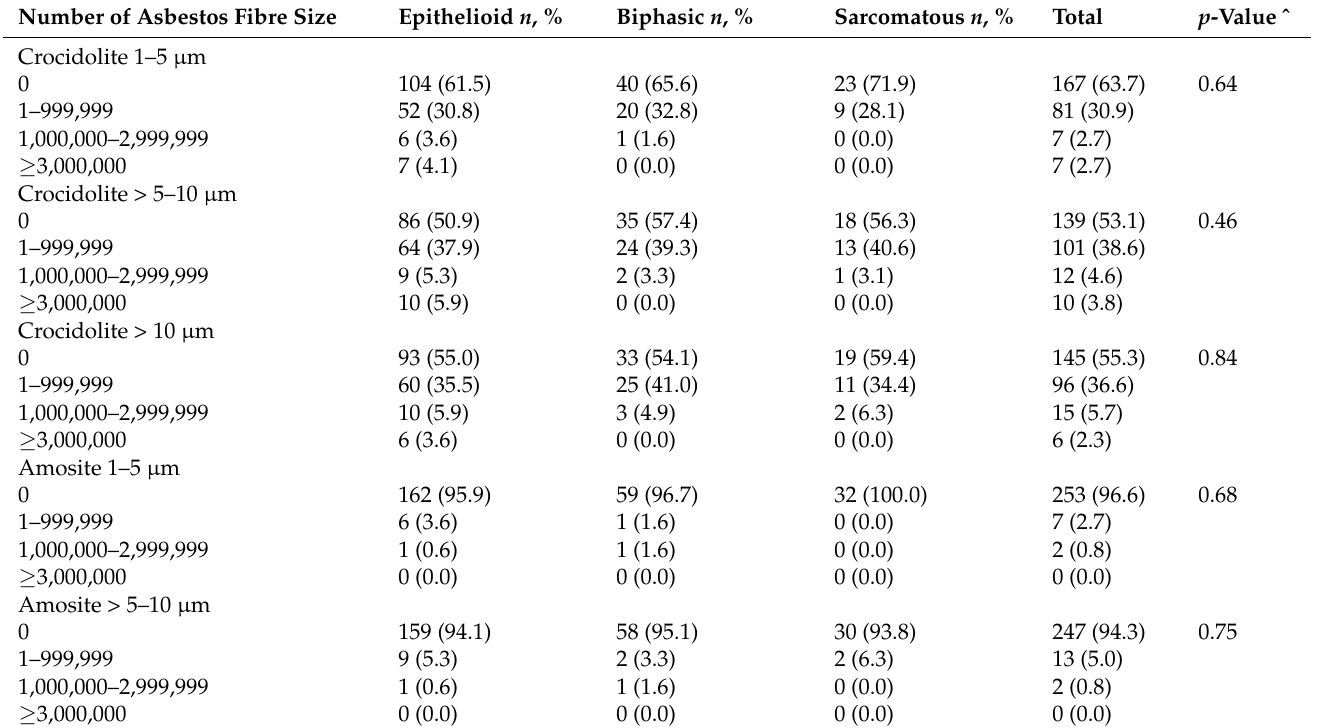
Table 10. Relationship between asbestos fibre size range and mesothelioma